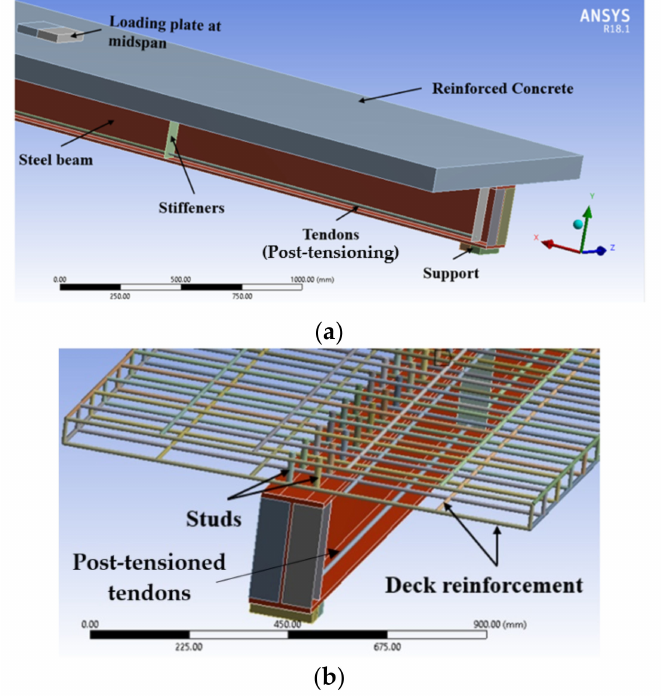
Figure 1. Details of the different components of the post-tensioned composite beam. ( a ) Longitudinal direction. ( b ) Transverse direction showing the deck